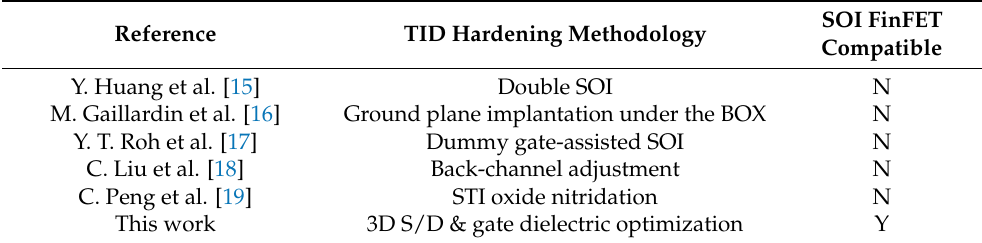
Table 1. Reported TID hardening methodology based on SOI technology and their compatibility with SOI